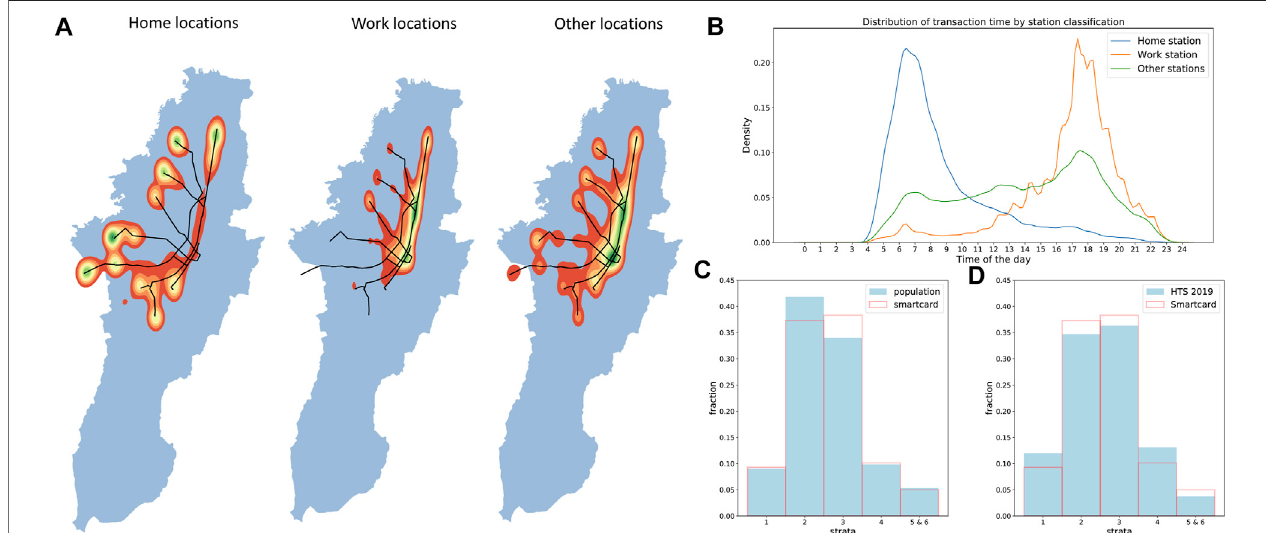
FIGURE 4 | Validation plots. (A) Density distribution of home, work and other locations. (B) Transactions time distribution for home, work and other locations. (C) Distribution of population by strata (DANE, 2018) and BRT user by strata by proposed methodology. (D) Distribution of BRT users by strata (Secretaria Distrital de Movilidad, 2019) and proposed